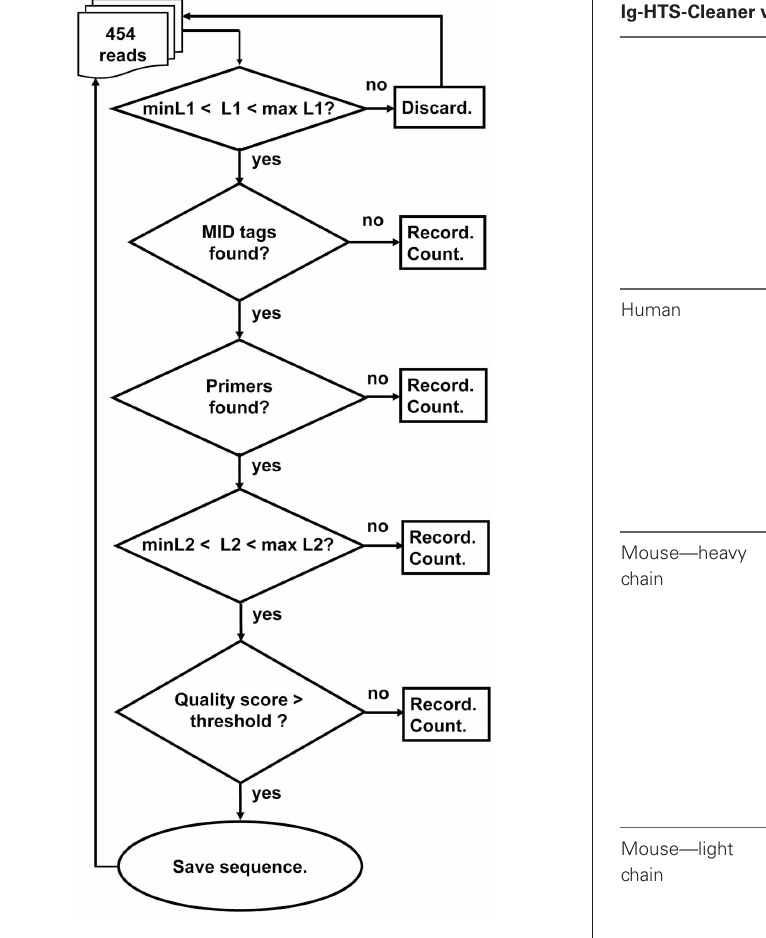
FIGURE 4 | A schematic outline of the Ig-HTS-Cleaner program algorithm. “Discard” means: discard the read because it is not likely to be